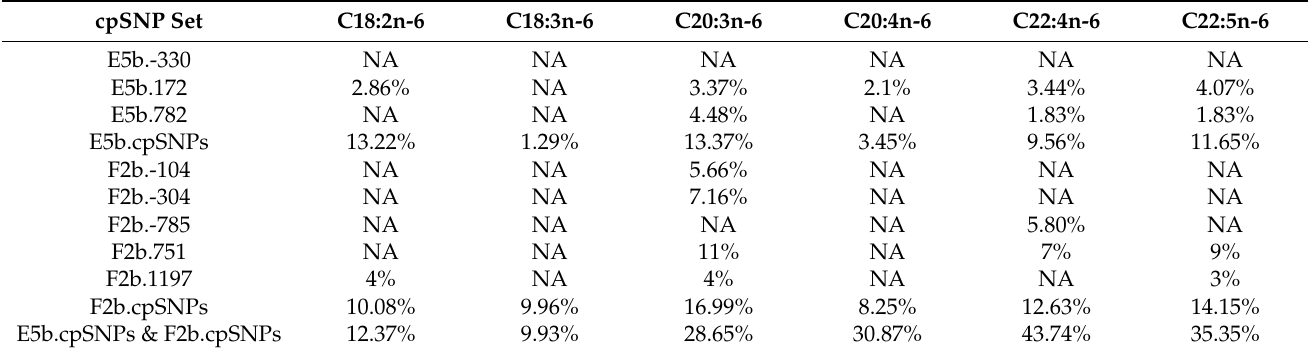
Table 4. The explained PVE of cpSNP set on the content of n-6 PUFAs.